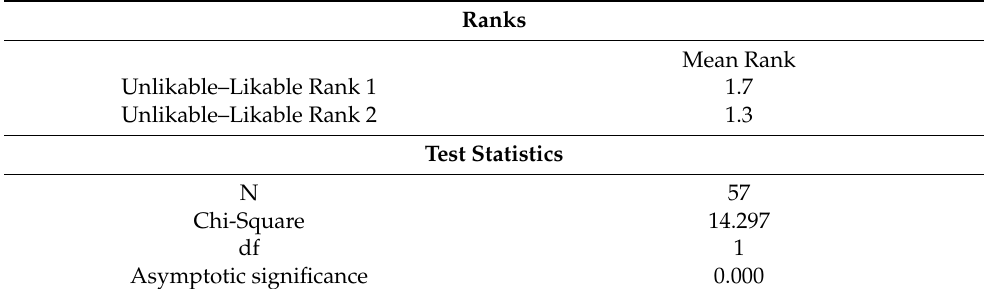
Table 8. The Friedman’s test result in terms of “unlikable–likable” for function “cover when coughing or